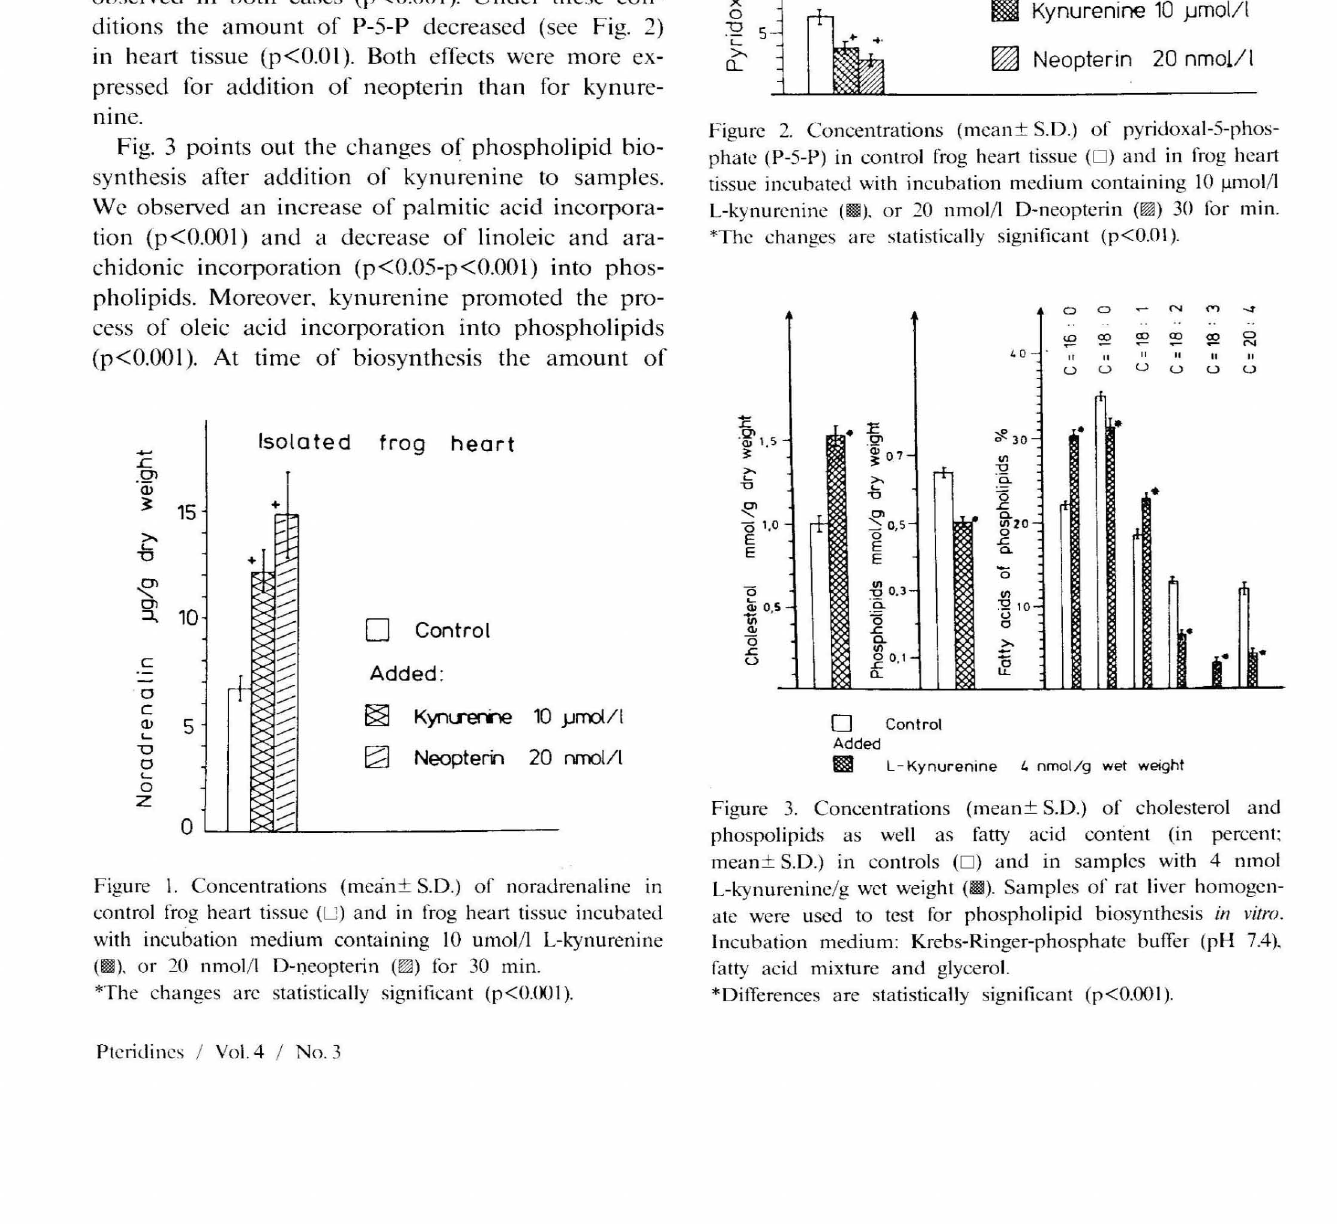
Figure I. Concentrations (mean± S.D.) of noradrenaline in control frog heart tissue (LJ) and in frog heart tissue incubated with incubation medium containing 10 umolll L-kynurenine (1m). or 20 nmolll D-I)eoptenn (~) for 30 min. *The changes arc statistically significant (p<O.(X)J).